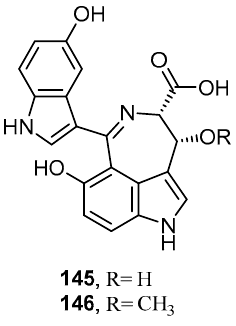
Figure 39. Chemical structures of hyrtinadine C ( 145 ) and hyrtinadine D ( 146 ).